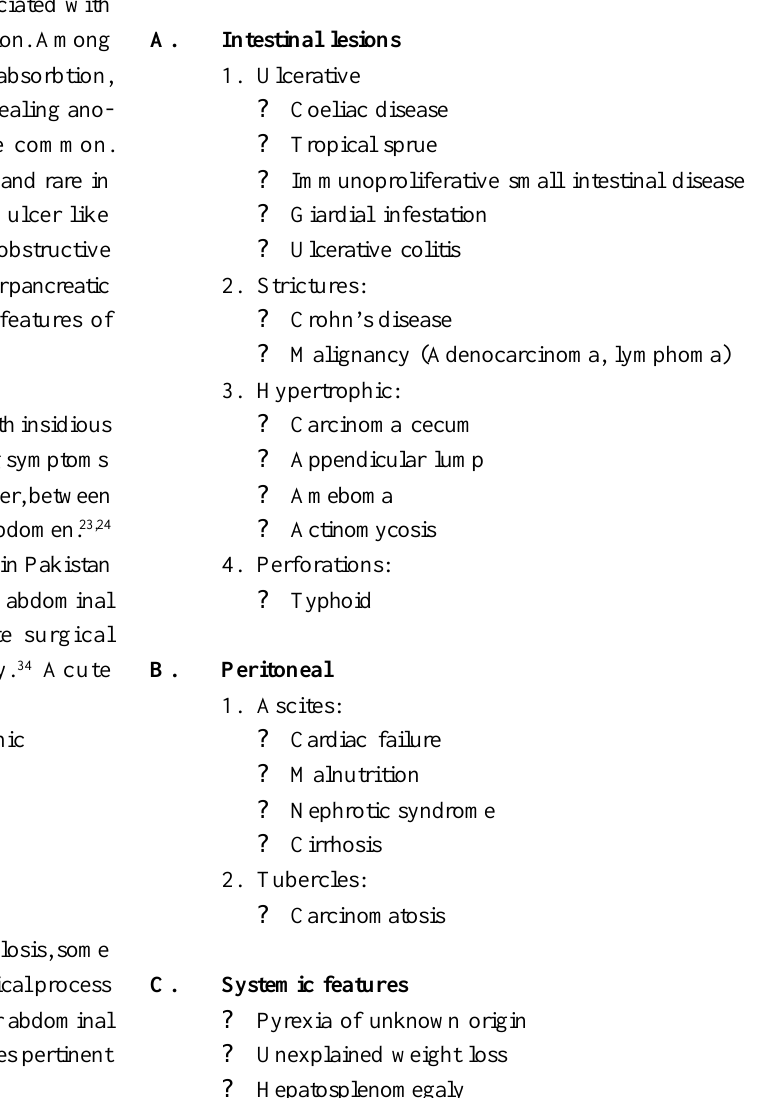
Table V : Differential diagnosis of Abdominal TB